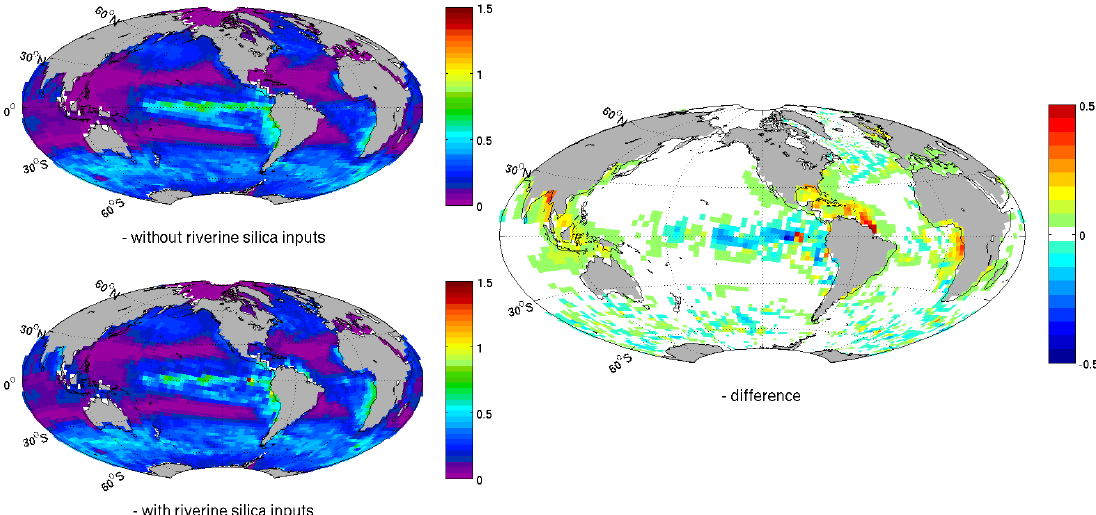
Fig. 5. Rivers contribution to the Opal export production in molSim − 2 yr − 1 – without silica riverine inputs (top-left) – with silica riverine inputs (bottom-left) and the computed difference with/without riverine silica inputs